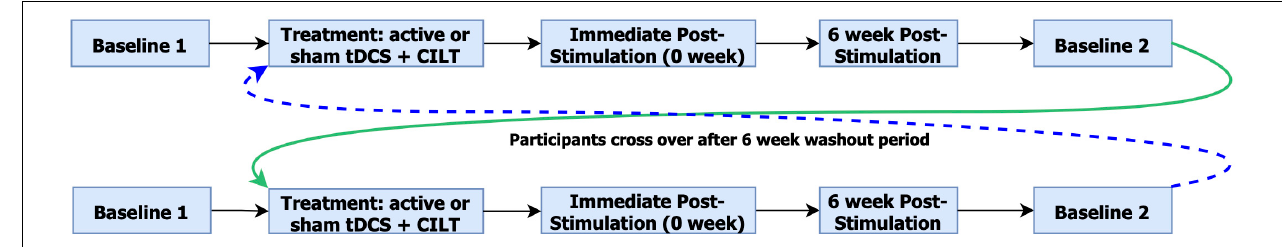
FIGURE 1 | Overview of study design. The color differentiation indicates arm 1 crossover to arm 2 and arm 2 crossover to arm 1.